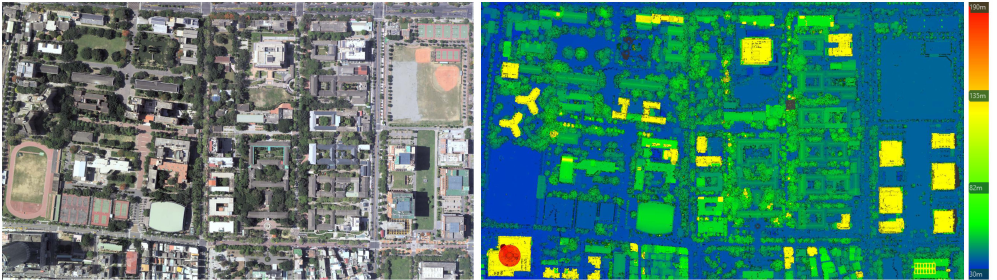
Figure 10. Study area. The aerial image ( left ) and corresponding point cloud ( right ).